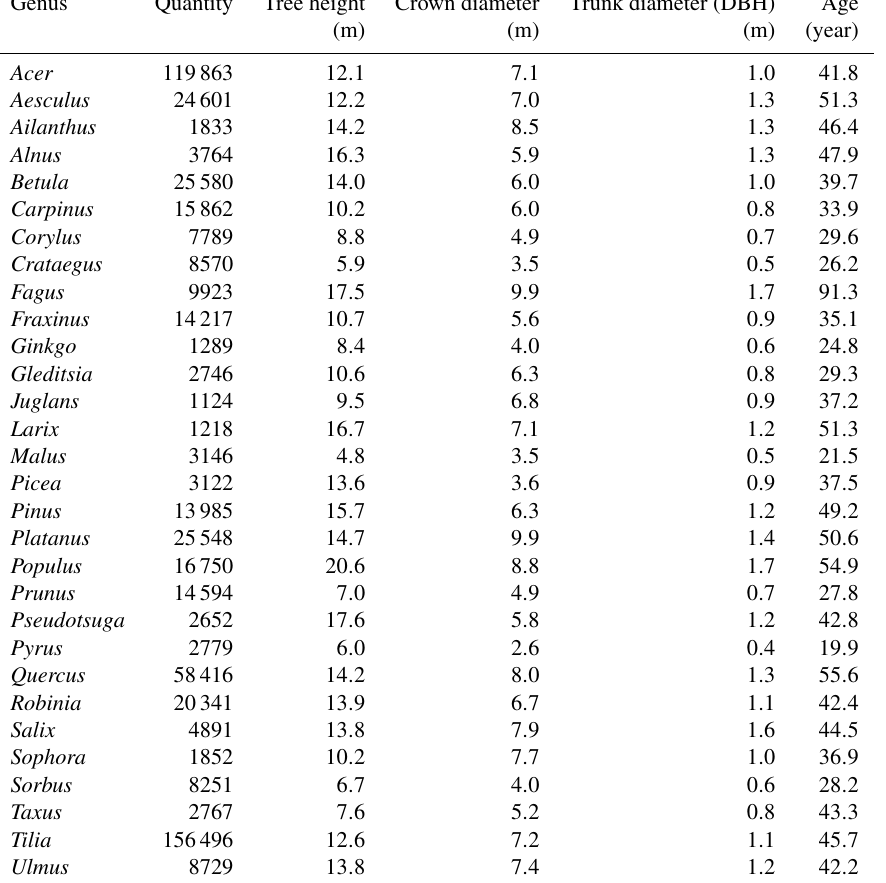
Table 5. List and average properties of the most common street trees in